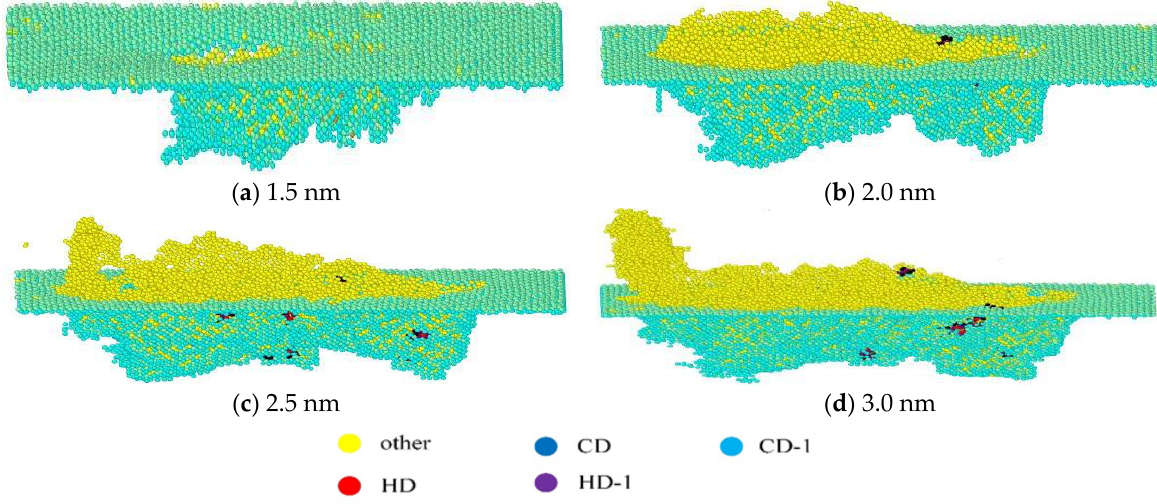
Figure 6. Atomic structure with different indentation depths.